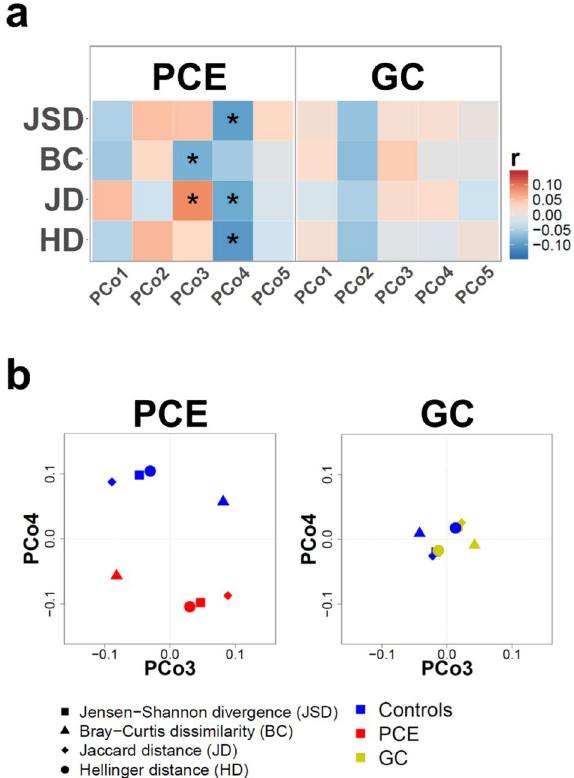
Figure 1. Cholecystectomy but not gallstone carrier status is associated with changes in beta diversity. ( a ) Heat map of point-biserial correlations between the group of individuals post-cholecystectomy (PCE, left) or gallstone carriers (GC, right) and beta diversity. The beta diversity indices Jensen-Shannon divergence (JSD), Bray–Curtis dissimilarity (BC), Jaccard distance (JD), and Hellinger distance (HD) were computed separately for PCE or GC cases and their respective control groups. The first five principle coordinates (PCo) are shown and significant correlations indicated by *. ( b ) Shown are the normalized PCo3 and PCo4 based on JSD, BC, JD, or HD for PCE (left) or GC (right). The centroids of PCE or GC cases are indicated by red or yellow symbols, respectively. The centroids of the respective control groups are displayed by blue